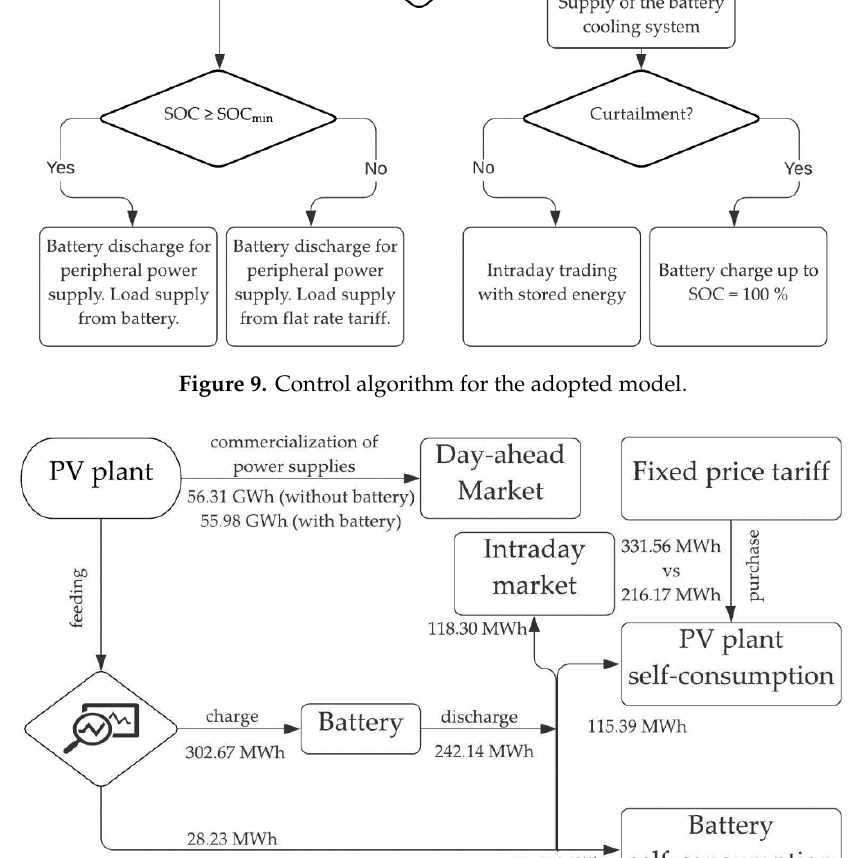
Figure 10. Diagram of energy distribution in the power grid. Table 5. Technoeconomic parameters for the adopted model.